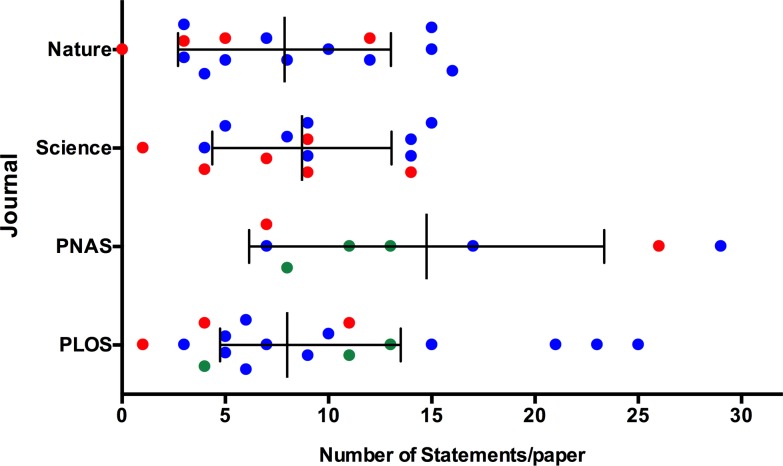
Quantitative comparative statements from results section of published research articles in major pan-discipline journals.The mean (middle vertical line) ± SD are shown. Physical science papers are denoted in red, Biological sciences are in blue, and Social sciences are in green.